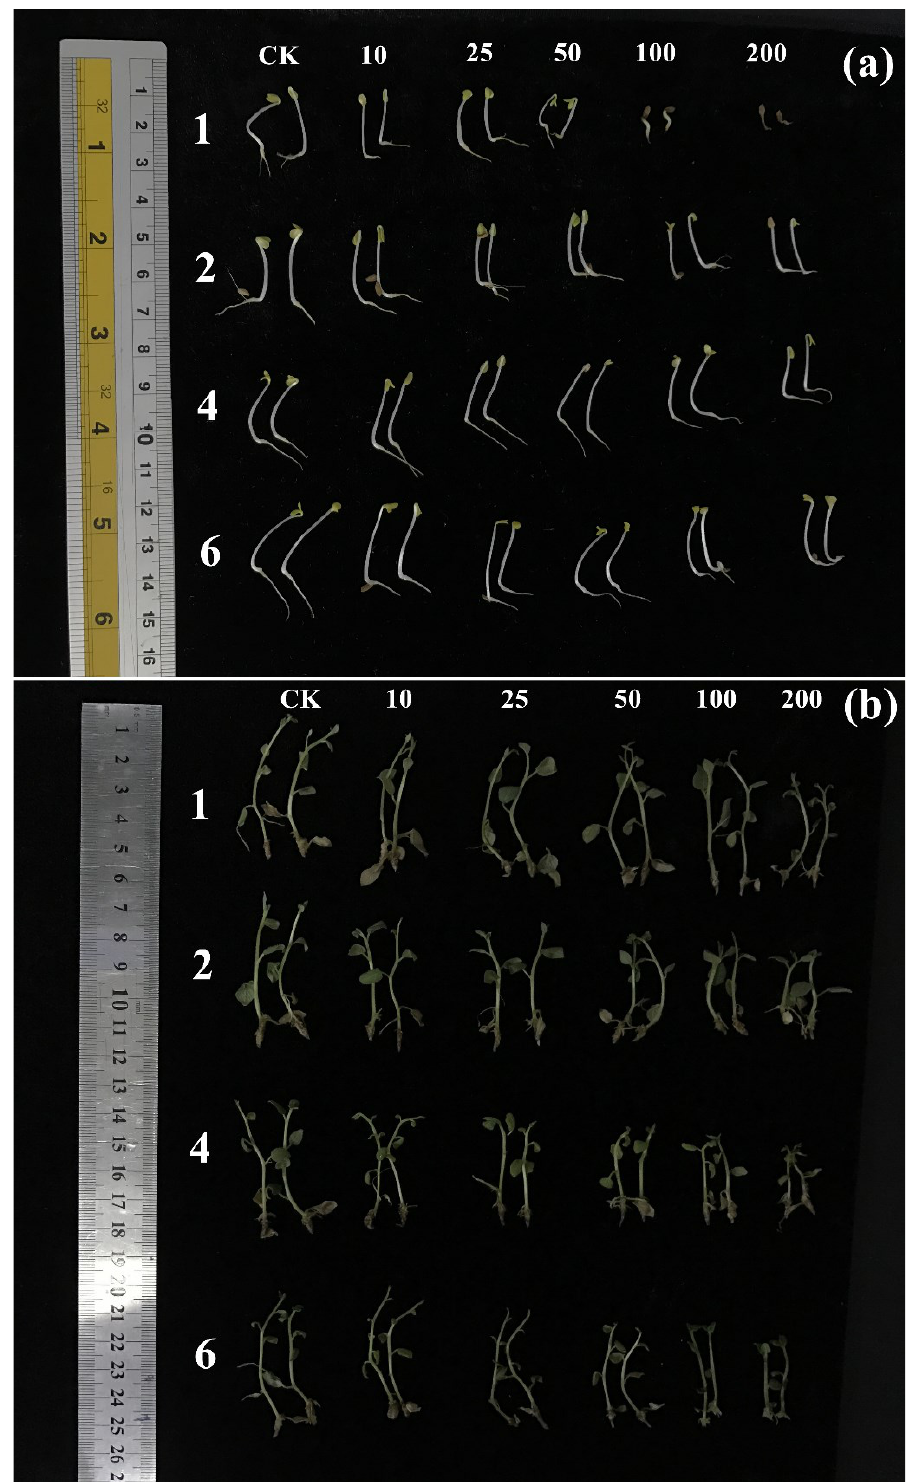
Figure 5. Typical pictures of the effects of compounds 1 , 2 , 4 and 6 on the growth of L. sativa seedlings ( a ) and potato tissue culture seedlings ( b ) at concentrations of 0, 10, 25, 50, 100, and 200 μg/mL. 2.5. Confirmation and Quantification of the Allelochemicals in the Rhizosphere Soil High-performance liquid chromatography (HPLC) was performed to quantify the allelochemicals in the rhizosphere soil of replanted potato. The presence of the com- pounds in the soil was confirmed by comparing the retention times of the standard com- pounds 1 , 2 , 4 , and 6 under the same chromatographic conditions (Figure 6). At the same time, the standard curve of the content of compounds 1 , 2 , 4 , and 6 was determined at a wavelength of 240 nm (compounds 1 , 2 , and 4 ) and 280 nm (compound 6 ) (Table 1). The